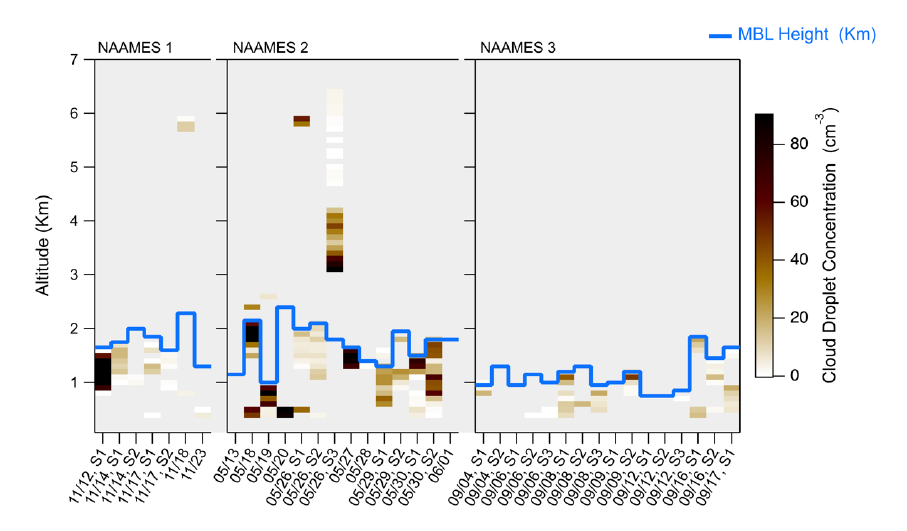
Figure 2. MBL and FT thermodynamic structure and vertical profiles of droplet concentration during NAAMES-1, NAAMES-2, and